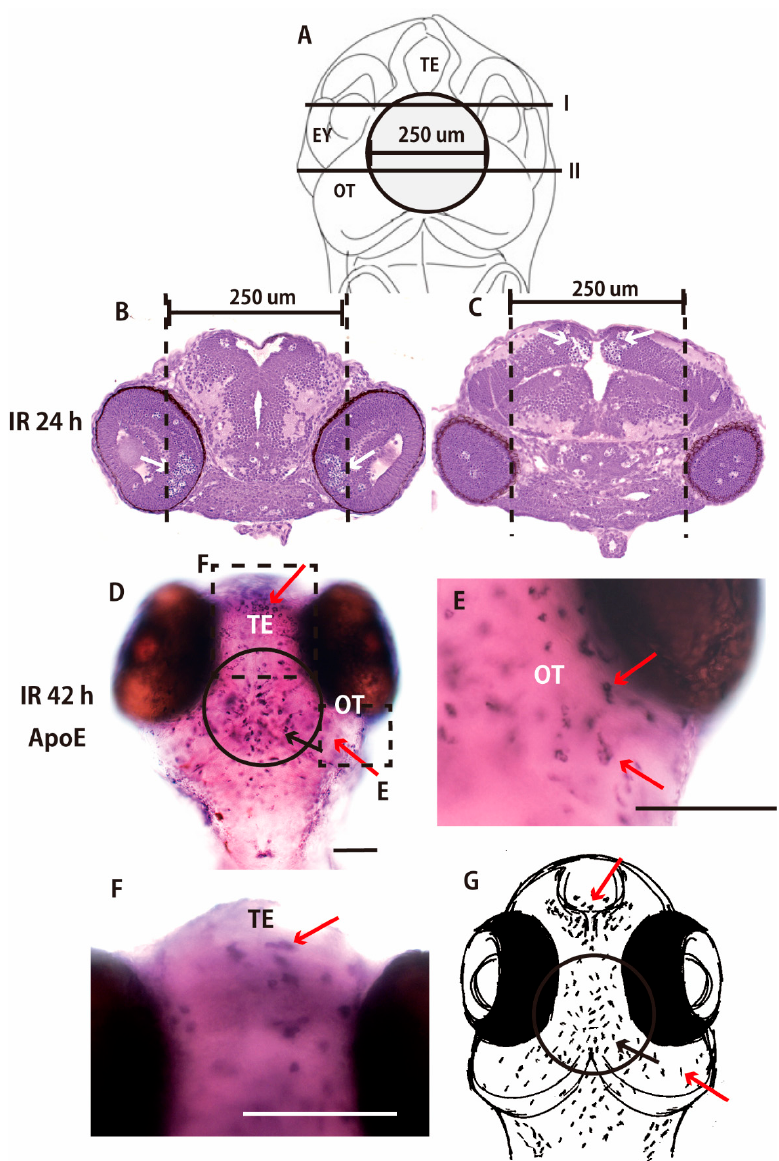
Figure 4. Irradiation targeted to the center of OT of medaka embryonic brain. Nissl-stained frontal sections of the brain 24 h after the targeted irradiation were prepared at the solid lines of I and II in ( A ) and shown in ( B , C ), respectively. Many pyknotic cells were induced in the limited area of the retina (arrows in B ) and the central part of OT (arrows in C ) where microbeam irradiation was targeted (dotted lines in B , C ). ApoE-expressing activated microglia at the late phase of phagocytosis were present 42 h after the irradiation, not only in the irradiated area of the central part of OT (circled area in D ), but also beyond the irradiated area of OT (red arrows in E ) and in the telencephalon (red arrow in F ). A schematic drawing of the abscopal effect of microglial activation is shown in G (red arrows in G ). Scale bars = 100 μ m.